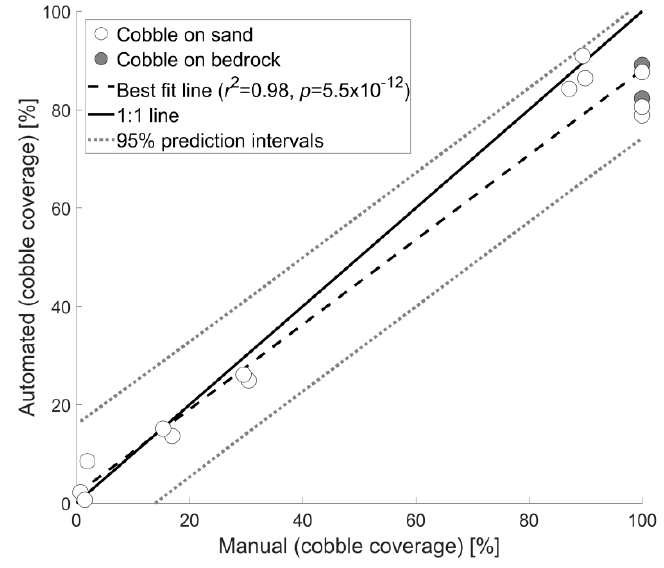
Figure 8. Comparison of MLi-20 automated and manual cobble mapping for a range of cobble densities and beach settings.